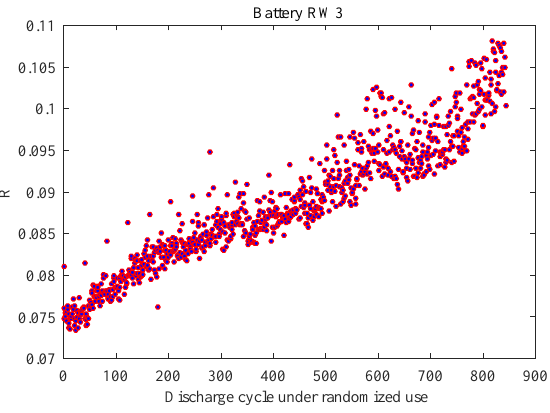
Figure 8. The results of R k of battery RW3.